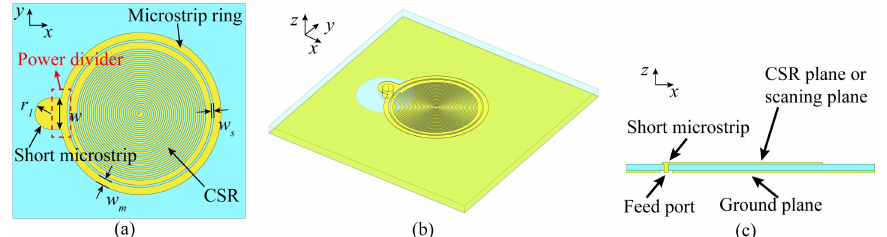
Figure 3. The sketch of the proposed probe: ( a ) the top view; ( b ) the three-dimensional view; ( c ) the cutaway